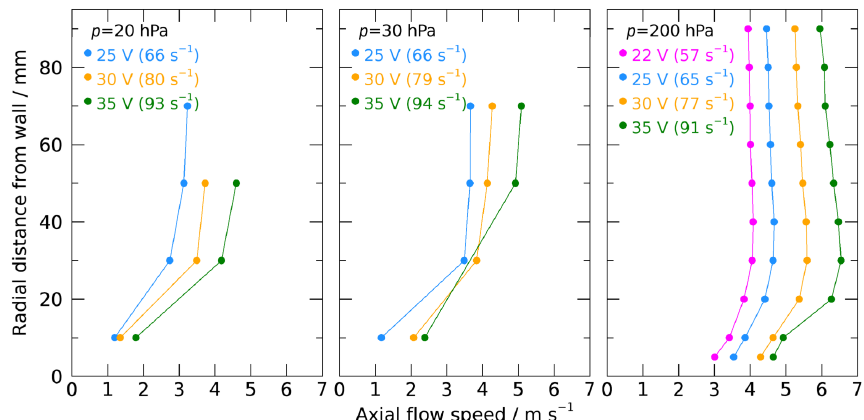
Figure 3. Examples of measured radial profiles of axial airflow in the test chamber at a position shortly before the sensor boom of the radiosonde. The three panels show results for different flow intensities at three different pressure levels. The flow velocities were generated by adjusting the fan voltage and thus its speed (in revolutions per second).